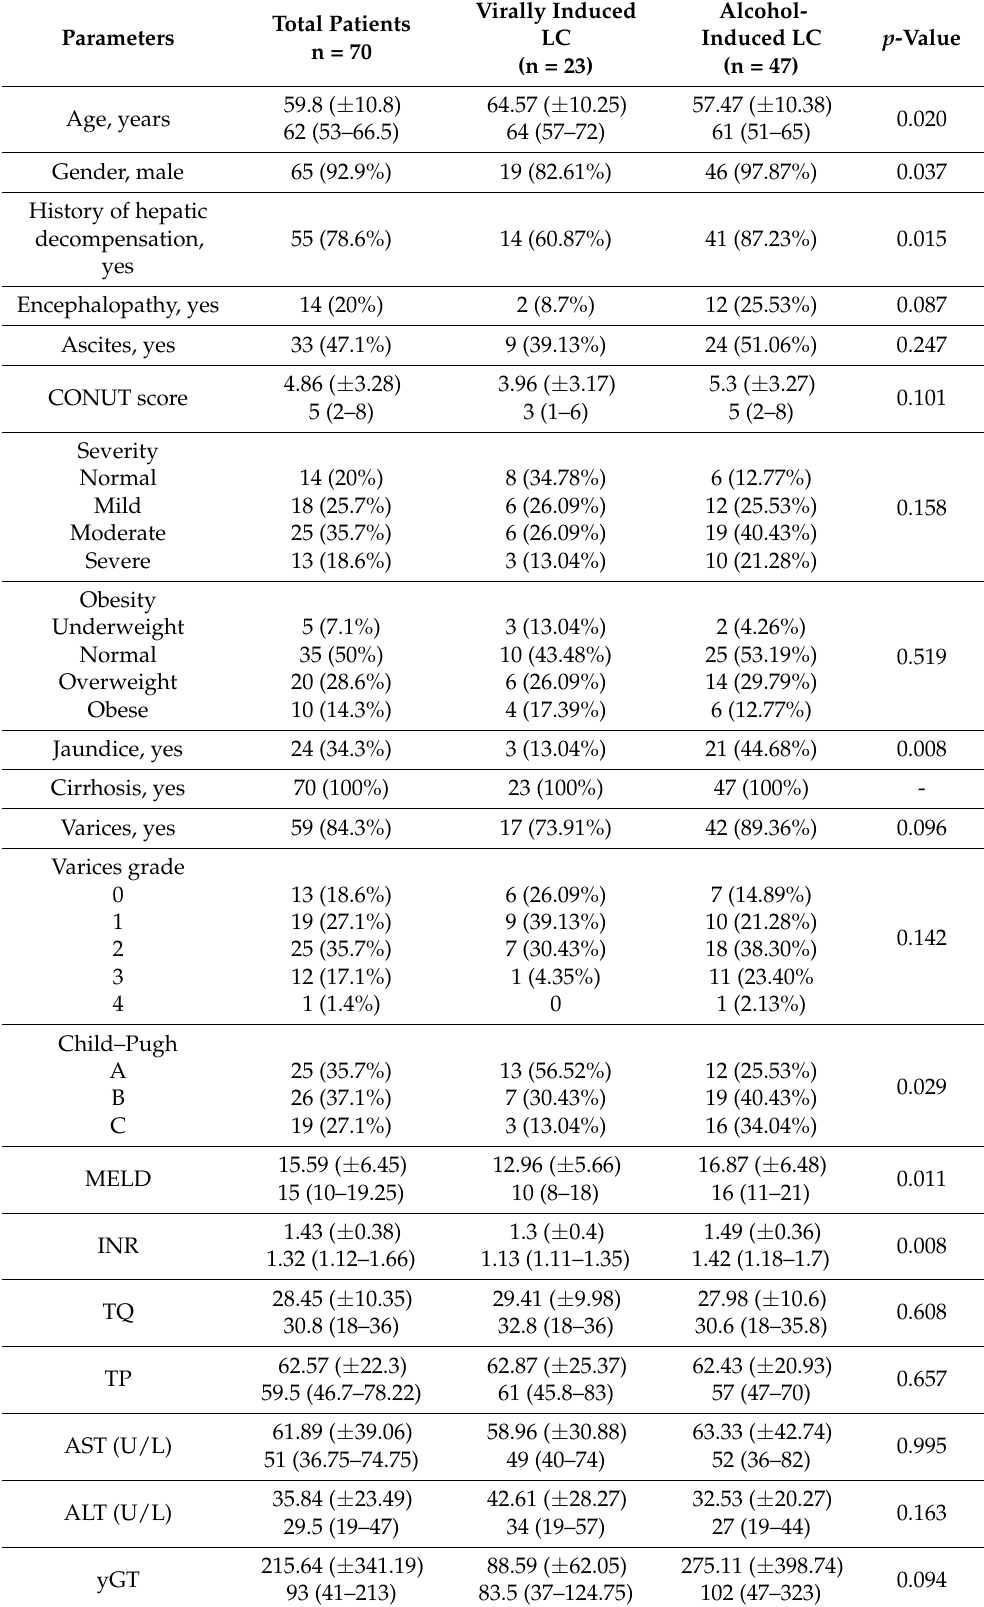
Table 1. Baseline data and comparison between viral and alcohol cirrhosis